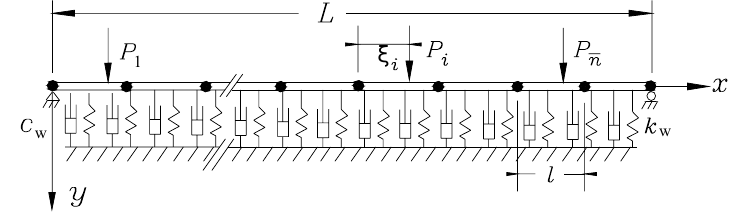
Fig. 2. Mathematical model for a uniform elastic Bernoulli-Euler beam on continuously viscoelastic foundation subjected to a number of concentrated moving loads.